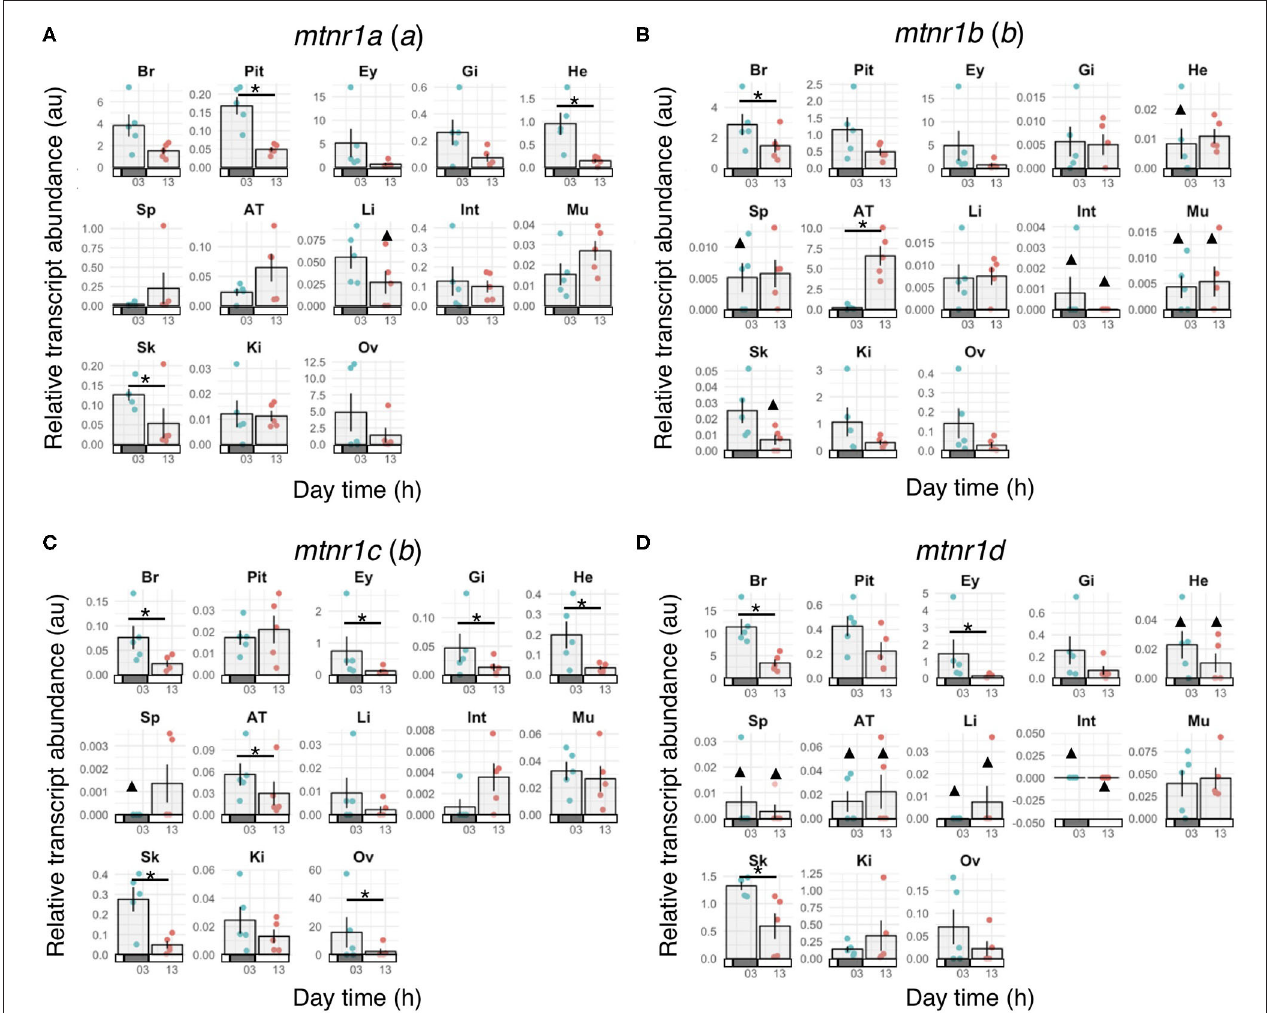
FIGURE 7 | Melatonin receptor expression profiles in mature female medaka during the day and night. Gene expression of the four melatonin receptor paralogs: (A) mtnr1a, (B) mtnr1b , (C) mtnr1c , and (D) mtnr1d in brain (Br), pituitary (Pit), eye (Ey), gill (Gi), heart (He), spleen (Sp), adipose tissue (AT), liver (Li), intestine (Int), muscle (Mu), skin (Sk), kidney (Ki), and ovary (Ov) of reproductively active medaka females. Fish were maintained under a prolonged photoperiod cycle of L14:D10 (light from 08:00 to 22:00) for one month prior to sampling and sampled either during the day (around 13:00) or the night (around 01:00) ( n = 5 per group). Bar plots represent the mean ± se of the relative transcript levels for the 5 fish and the dots show the individual data points depending on the sampling time. Night sampling is indicated with blue dots and day sampling with pink dots. Bars along the x-axes represent the light phase (open bars) and dark phase (solid bars). Statistically significant changes in gene expression between day and night (Wilcoxon rank sum test) are indicated by an asterisk (*). Triangles ( N ) indicate groups for which gene expression was detected in less than 3 out of 5 fish. Statistical comparisons were not done for these groups. The letter inside the parentheses indicates the 3R paralog